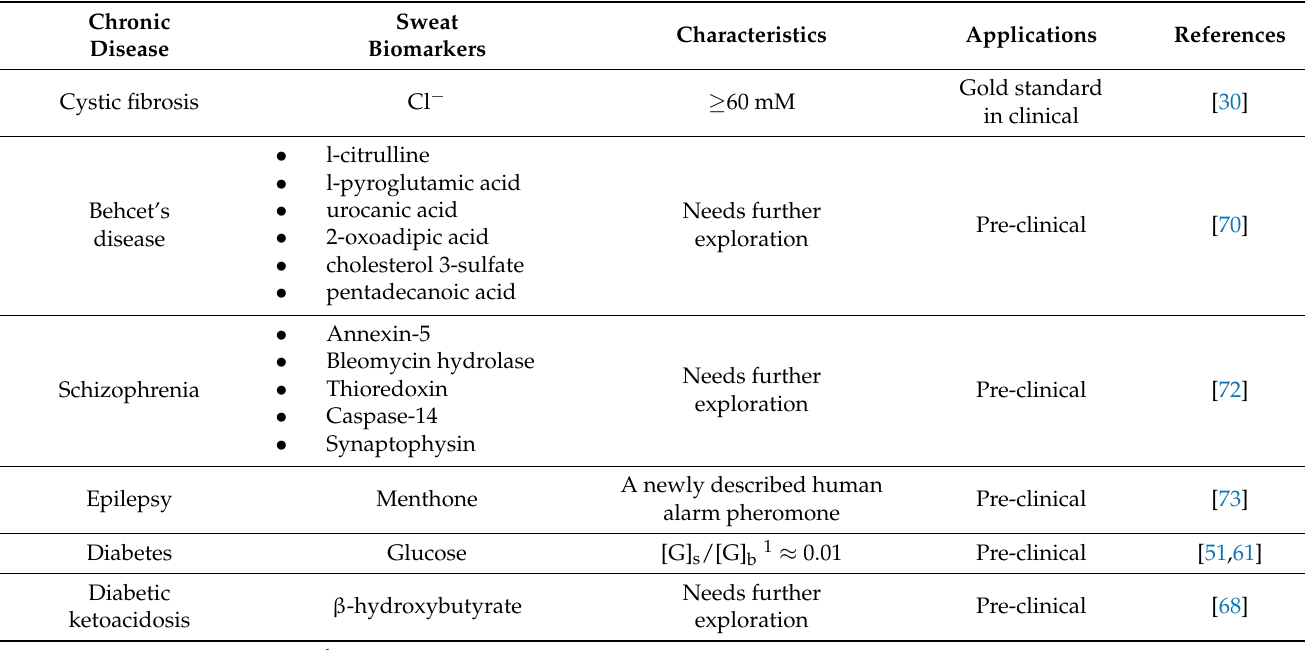
Table 1. Clinical uses and potential sweat biomarkers of chronic